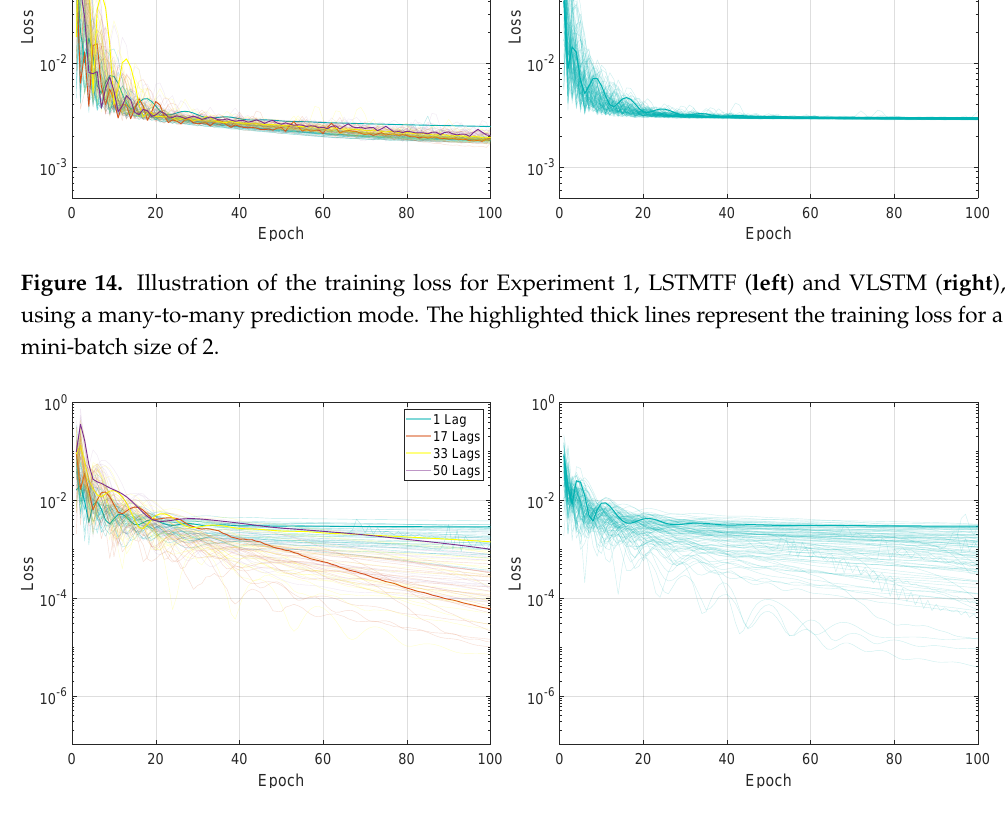
Figure 15. Illustration of the training loss for Experiment 1, LSTMTF ( left ) and VLSTM ( right ), using a many-to-one prediction mode. The highlighted thick lines represent the training loss for a mini-batch size of